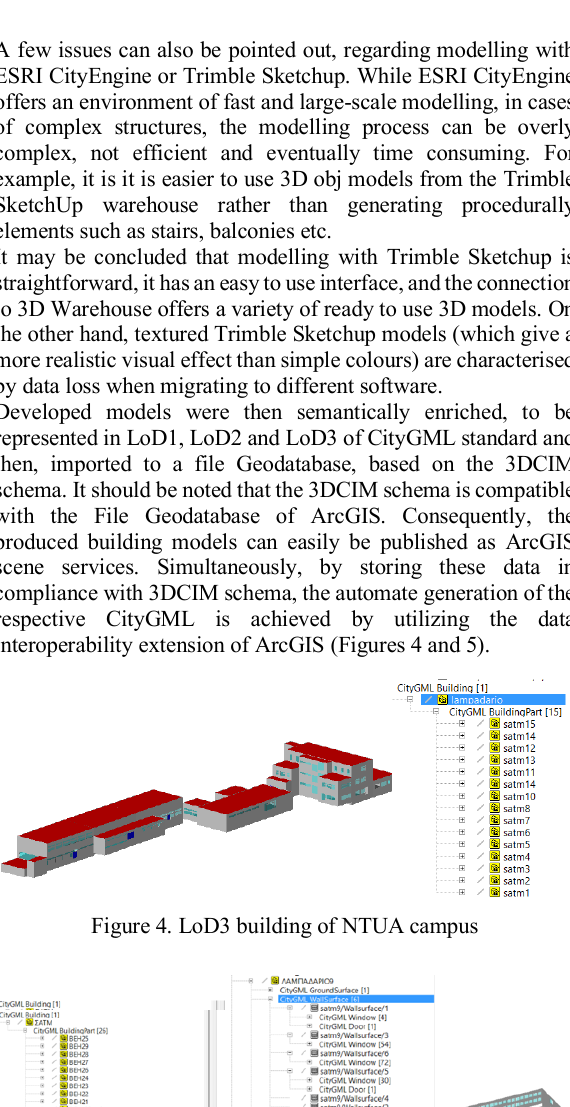
Figure 3. Web CGA Generator tool